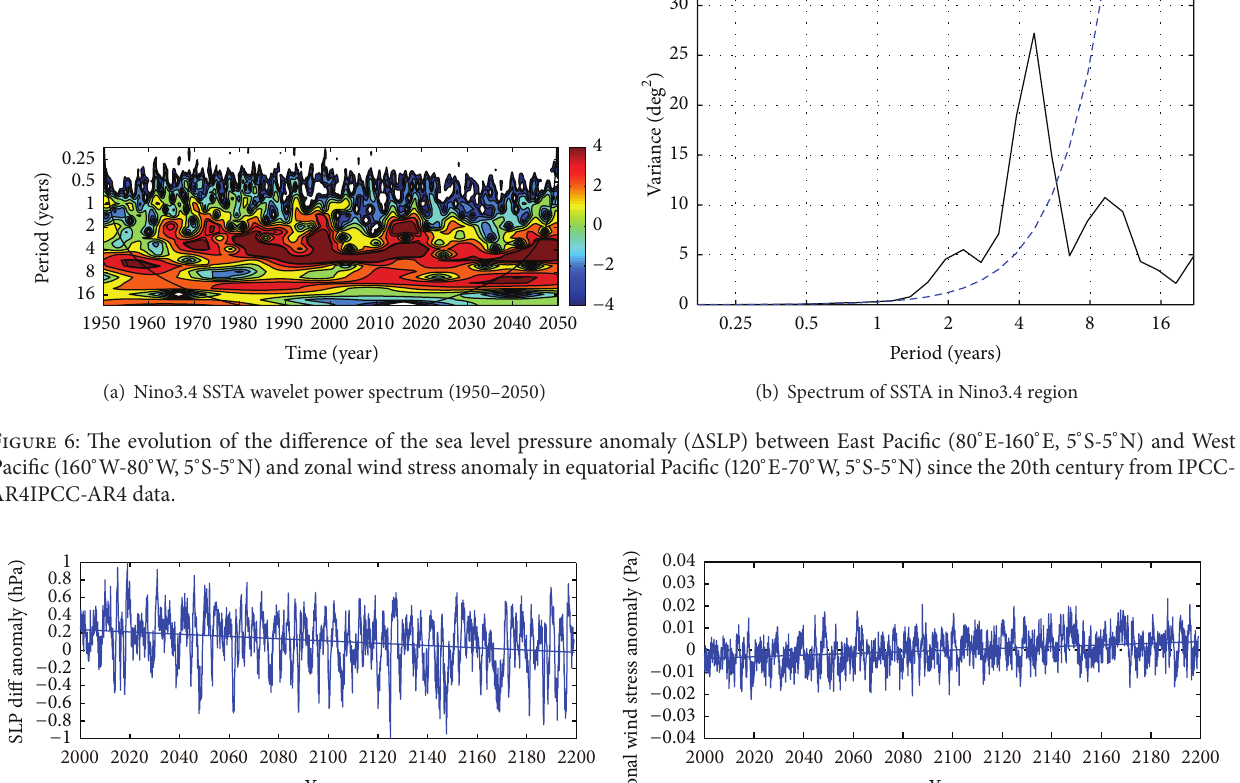
(Figure 2). The largest domain covers the Pacific Ocean with ∘ ×1.44 ∘ in zonal and meridional directions, a grid size of 2.88 respectively. The second and third domains embedded within the Pacific domain use a grid size of 0.72 ∘ × 0.36 ∘ and 0.18 ∘ × 0.09 ∘ covering the Eastern Pacific Ocean. Finally, the